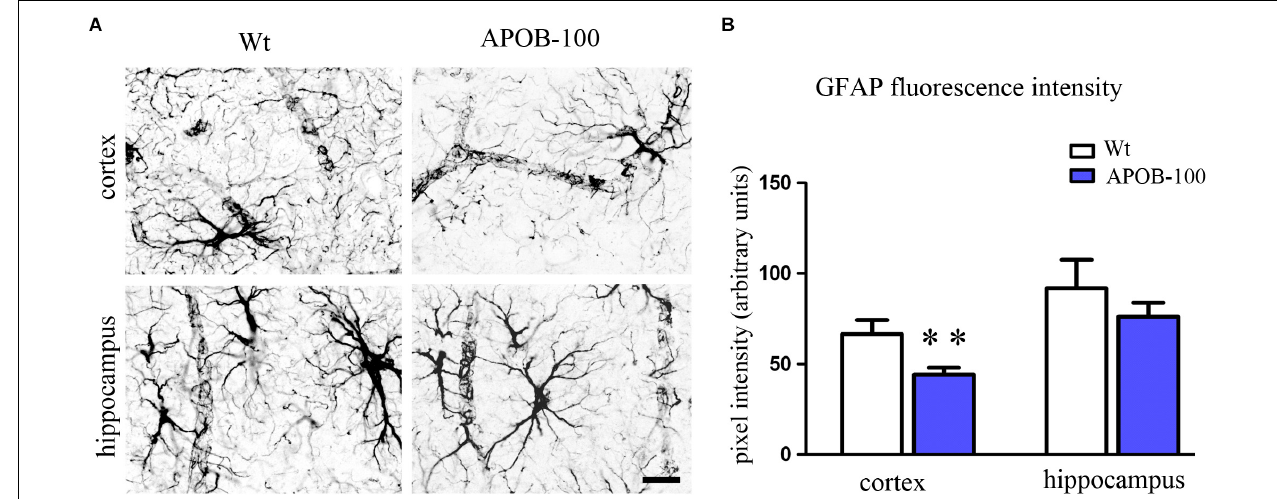
FIGURE 7 | Gfap immunostaining pattern in the cortex and hippocampus of wild-type (Wt) and APOB-100 transgenic mice (APOB-100) (A). Scale bar: 25 µ m. Quantification of fluorescence intensity of Gfap immunolabeling in the frontal cortex and hippocampus of Wt and APOB-100 transgenic mice (B) . ∗∗ P < 0.01 compared with Wt